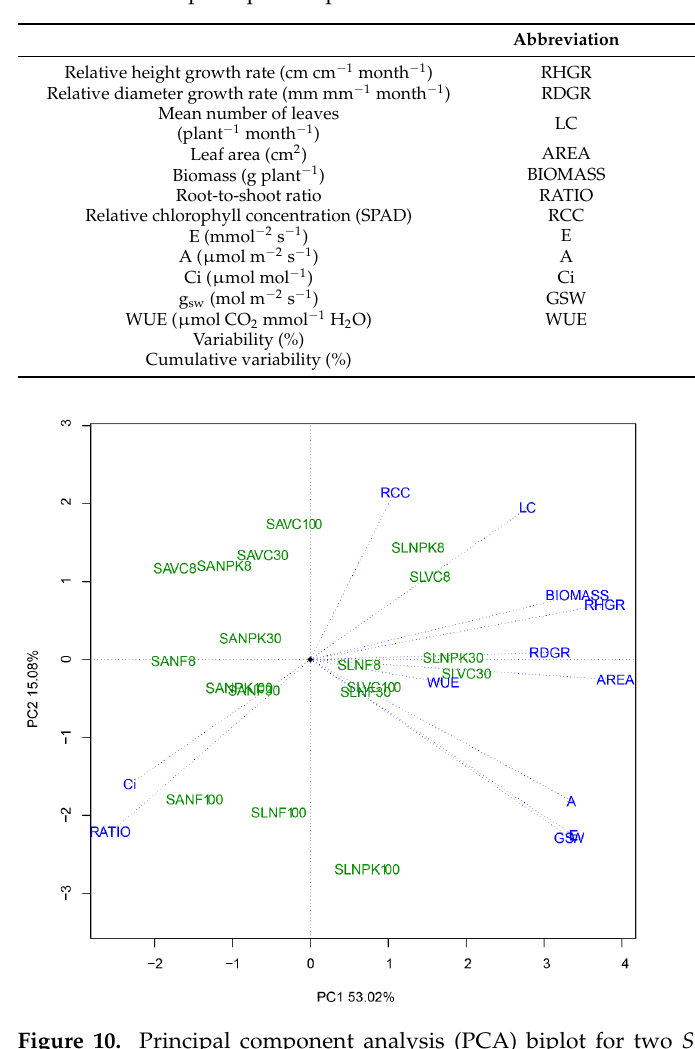
Figure 10. Principal component analysis (PCA) biplot for two Shorea species, S. leprosula (SL) and S. acuminata (SA), growing under different levels of light irradiance (8%, 30%, 100%) and nutrient amendments (NF, NPK, VC). Growth responses: relative height growth rate (RHGR) (cm cm − 1 month − 1 ), relative diameter growth rate (RDGR) (mm mm − 1 month − 1 ), mean number of leaves (LC) (plant − 1 month − 1 ), leaf area (AREA) (cm 2 ), biomass (g plant − 1 ), Root-to-shoot ratio (RATIO), and relative chlorophyll concentration (RCC) (SPAD). Gas exchange measurements: photosynthesis rate (A, µ mol m − 2 s − 1 ), transpiration rate (E, mmol − 2 s − 1 ), stomatal conductance (g sw , mol m − 2 s − 1 ), water-use efficiency (WUE, µ mol CO 2 mmol − 1 H 2 O), and intercellular carbon concentration (Ci µ mol mol − 1